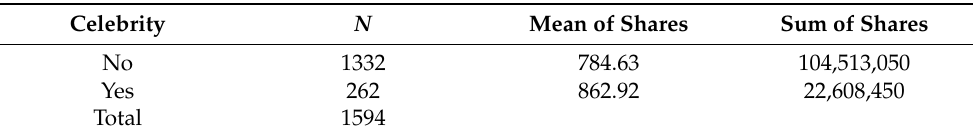
Table 2. Total and mean number of shares of stories that feature celebrities versus stories with- out celebrities.